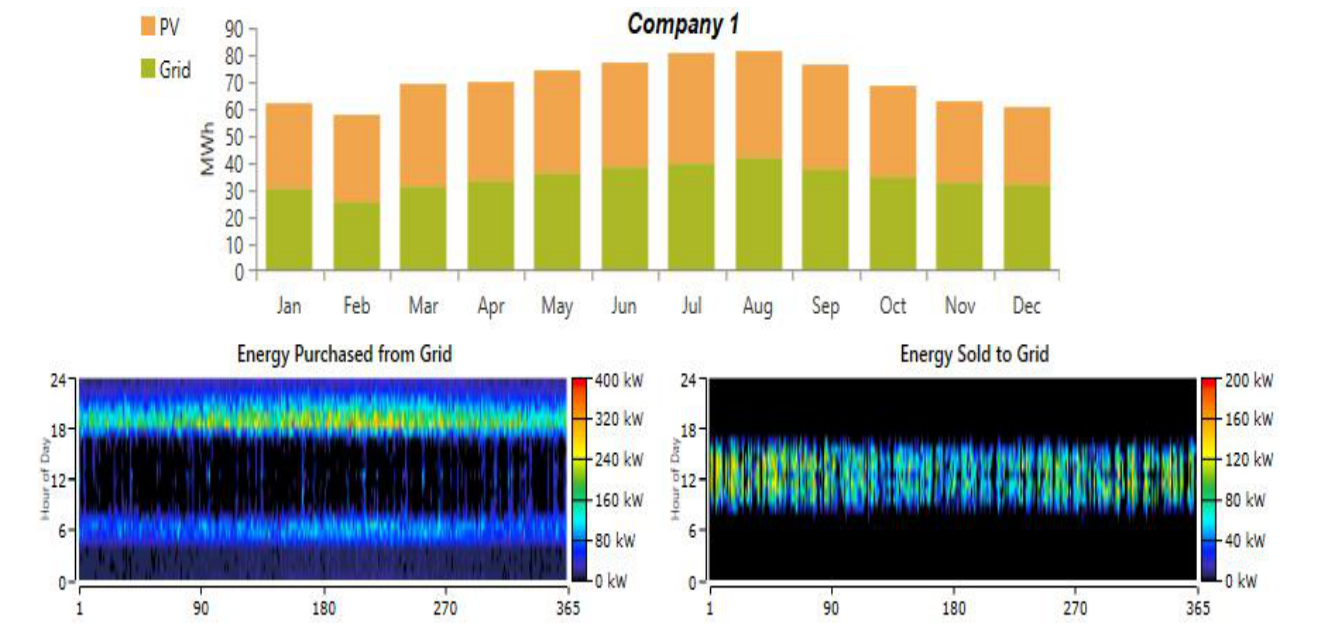
Figure 10. Company 1 system production, 2021. Table 5. The cost summary of the project in the